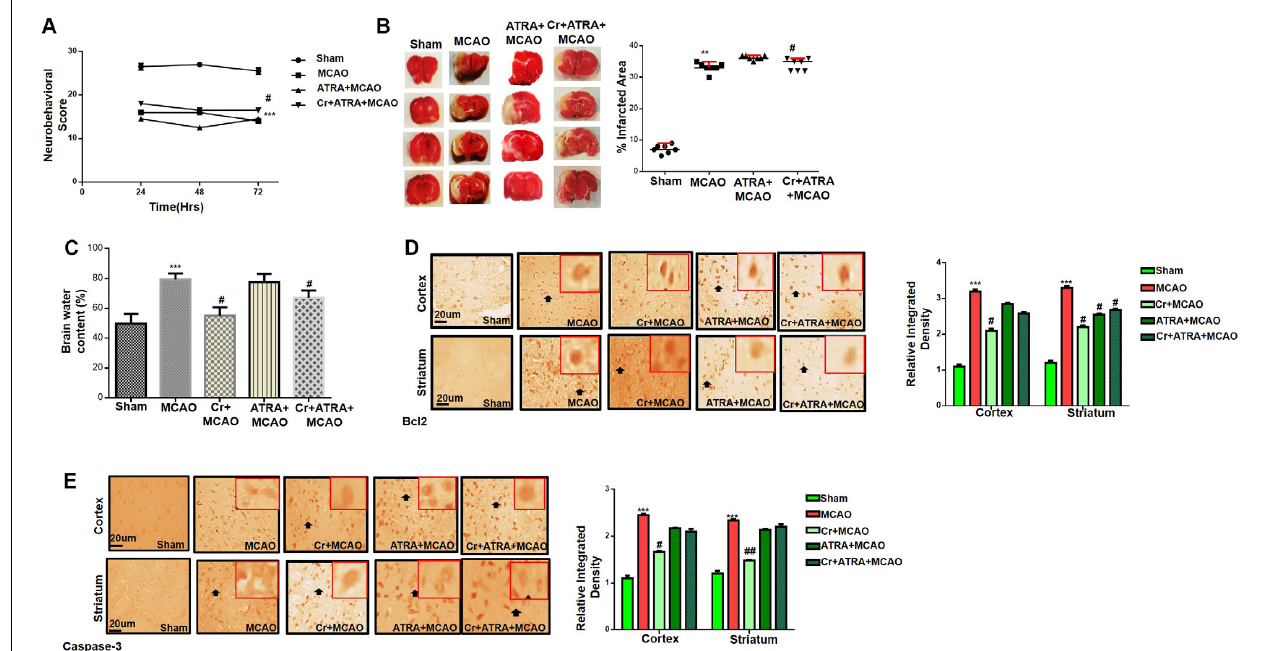
FIGURE 3 | Effects of ATRA on carveol mediated neuroprotection. (A) 28 points composite scoring. ATRA + MCAO rats had significantly severe neurological deficits than MCAO rats had ( p < 0.01). Neurological score data is presented as mean ± SEM and analyzed by two-way ANOVA (group analysis) ( n = 7/group). Carveol used as 20 mg/kg and ATRA as 5 mg/kg. (B) Brain coronal sections were stained with TTC, which distinguishes between ischemic and non-ischemic areas ( n = 7/group). Carveol used as 20 mg/kg and ATRA as 5 mg/kg. Data are presented as mean ± SEM and analyzed by one-way ANOVA. ** p < 0.01 and # p < 0.05. Symbols * shows significant difference relative to sham while # shows significant difference relative to MCAO. (C) The brain water content of the cerebral hemisphere in the ischemic side was calculated by the wet and dry method in each group ( n = 5/group). Carveol used as 20 mg/kg and ATRA as 5 mg/kg. Data are presented as mean ± SEM and analyzed by one-way ANOVA. *** p < 0.001 relative to the sham group; # p < 0.05 relative to the MCAO group. (D) Immunohistochemistry results for Bcl-2 in cortex and striatum. Scale bar 50 µ m, magnification 40 × . (E) Immunohistochemistry results for caspase-3 in cortex and striatum. Scale bar 50 µ m, magnification 40 × ( n = 5/group). Carveol used as 20 mg/kg and ATRA as 5 mg/kg. Data are presented as mean ± SEM and analyzed by two-way ANOVA followed by post hoc Bonferroni multiple comparison test using GraphPad Prism 6 software. Both Bcl-2 and caspase-3 exhibited cytoplasmic localization in both tissues. Immuno slides were made by processing TTC thick coronal sections which were fixed in 4% paraformaldehyde. From the thick coronal TTC sections, paraffin blocks were made, and later 4 µ m thin coronal sections were prepared by a rotary microtome. *** p < 0.001 shows significant difference relative to sham, # p < 0.05, and ## p < 0.01 shows significant difference relative to MCAO group.